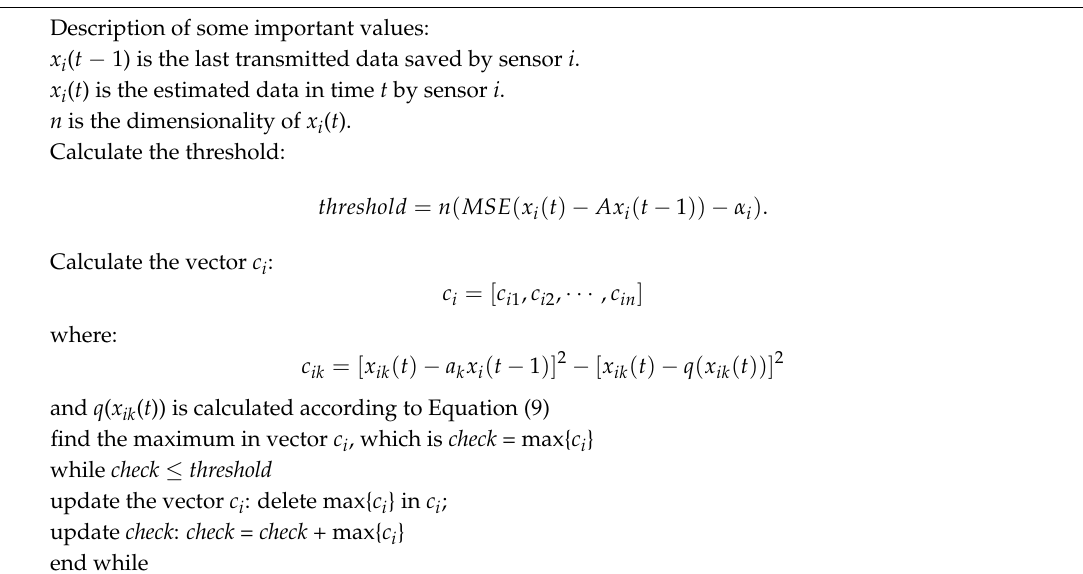
Algorithm 1 Order-based Algorithm. For given s , τ , u , and ρ to determine the quantization function q ( x ), and for given the threshold α i